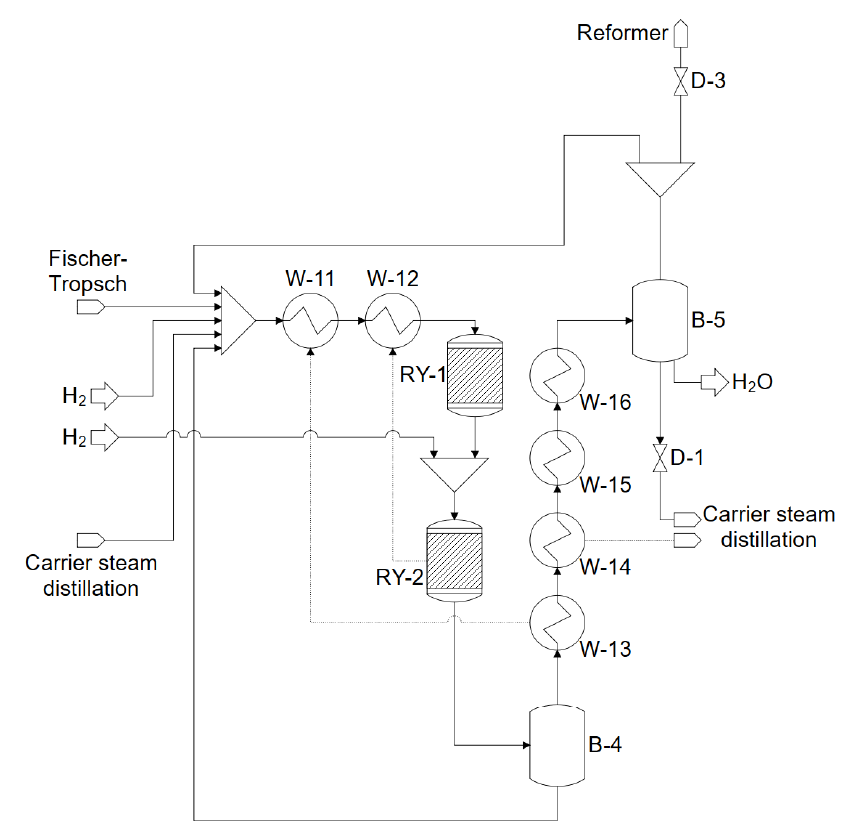
Figure 5. Excerpt from the process flow diagram: hydrocracker.